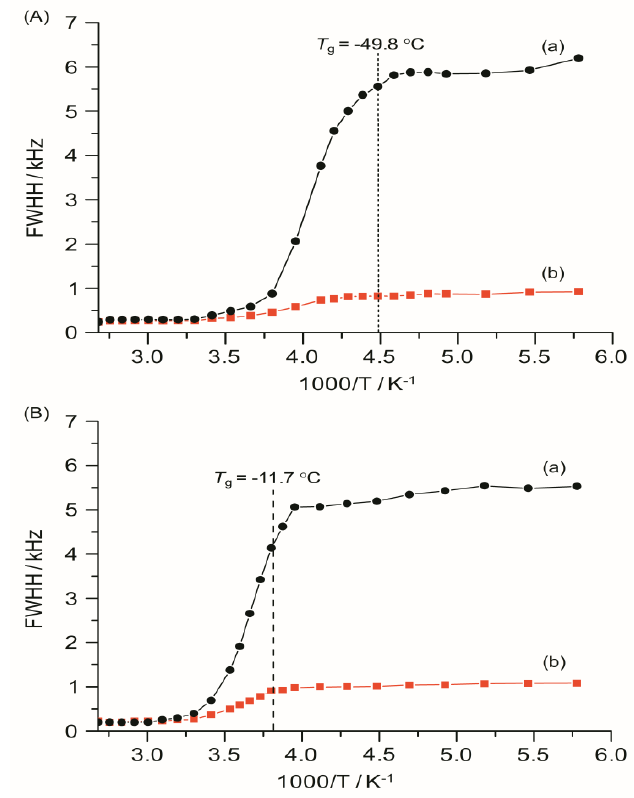
values obtained from g